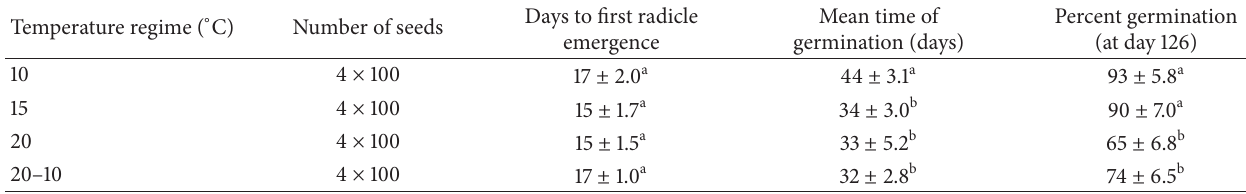
Table 2: The effect of temperature regime on the germination characteristics of Calluna vulgaris seeds under a photoperiod of 8h. Storage periodatroomtemperaturebeforetrial:6days.Meanvalues ± standarddeviations.Ineachcolumn,groupsthatshowedsignificantdifferences ( 𝑃 < 0.05 ) are indicated with different